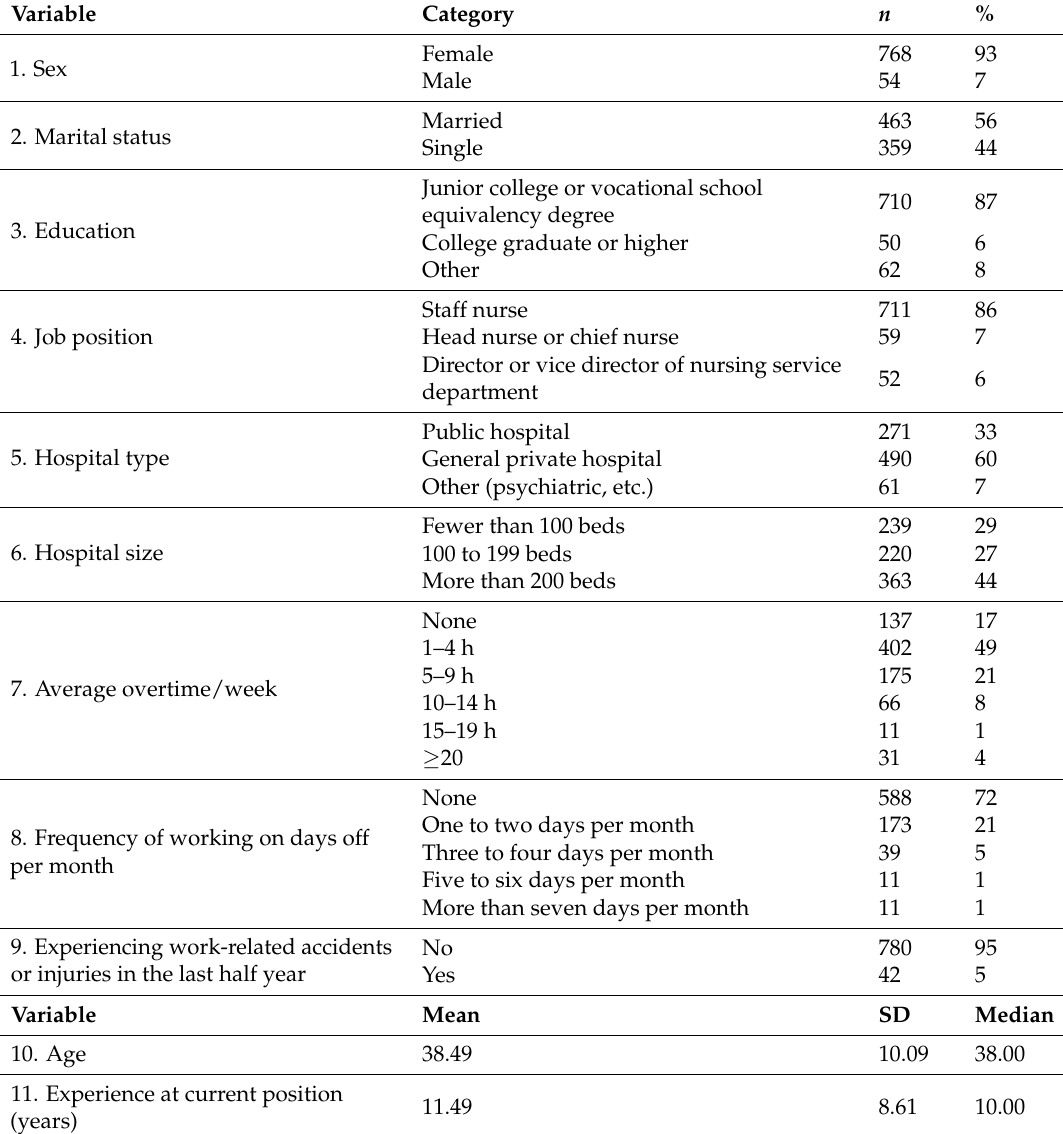
Table 1. Participants’ basic characteristics ( n = 822).